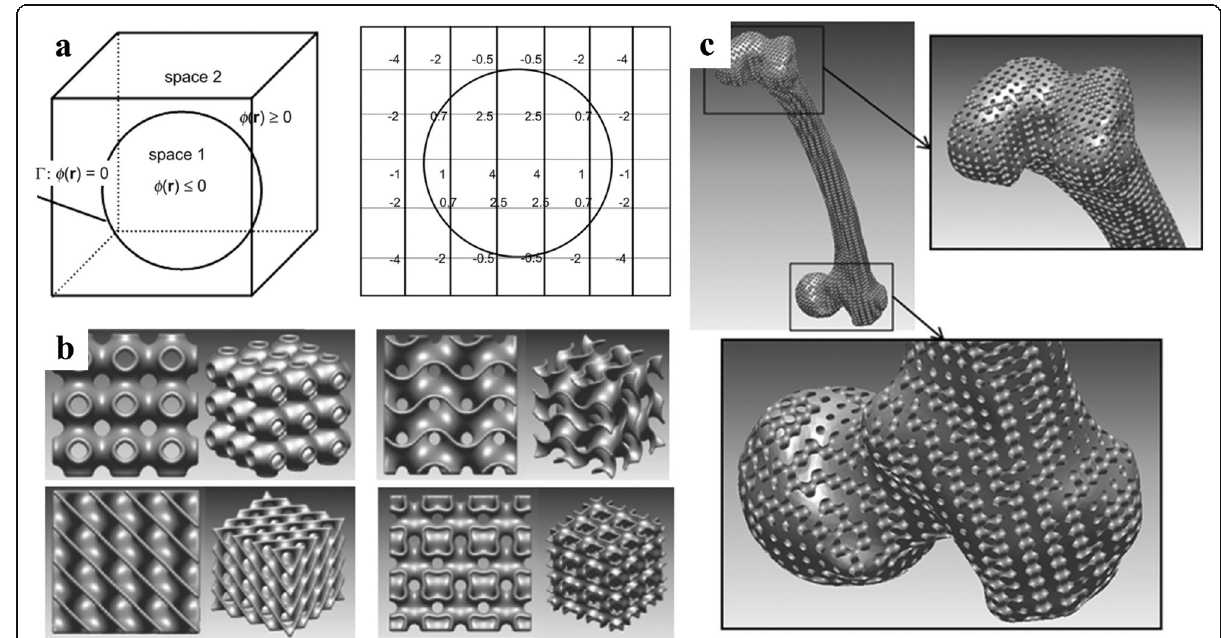
Fig. 12 Porous scaffold design by the distance field and TPMS: a Schematic diagram of the distance field. b TPMS units. c Femur bone scaffold composed of P-surface internal architecture [32]